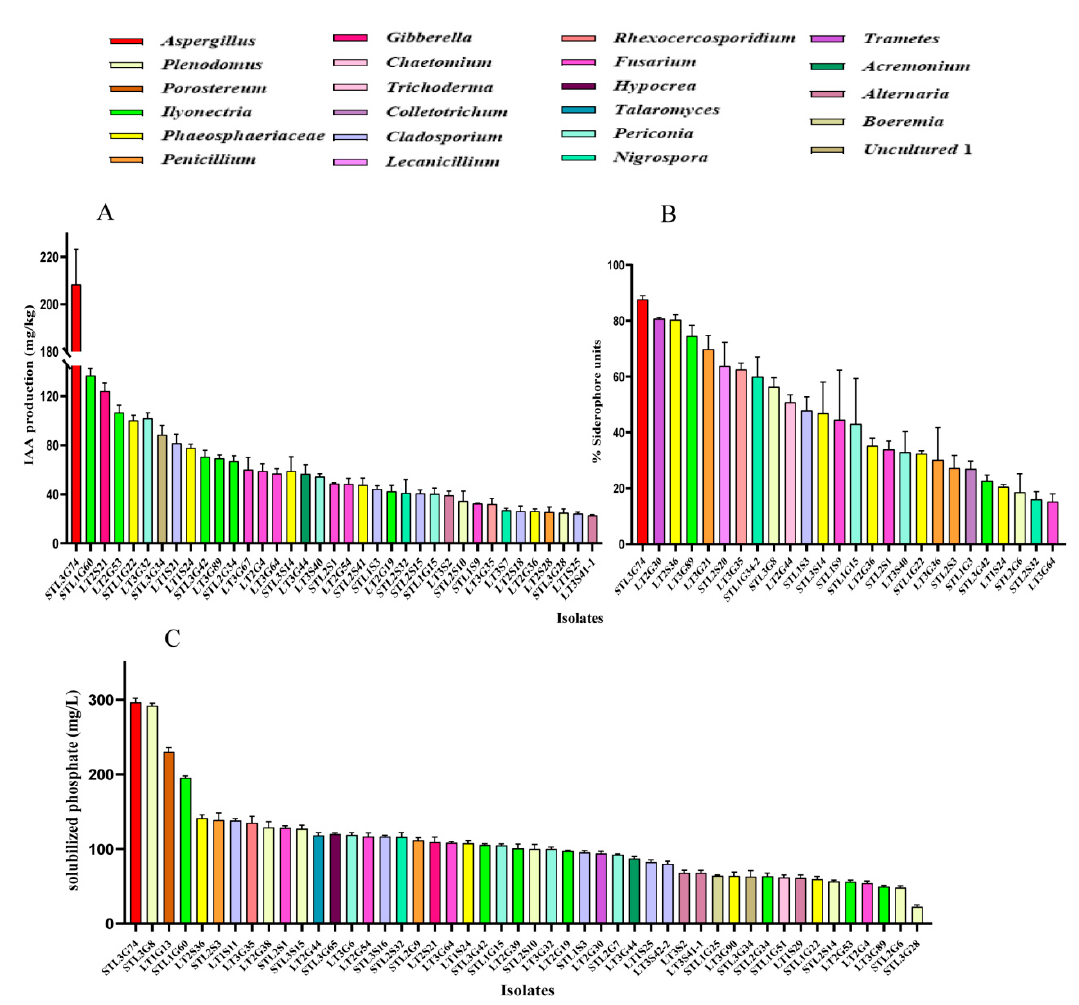
Figure 5. The IAA production ( A ), siderophores production ( B ) and phosphorus solubilization ( C ) activity of fungal endophytes of S. chamaejasme . Error bars represent standard deviation ( n = 3). The same colors indicate they belong to the same genus.